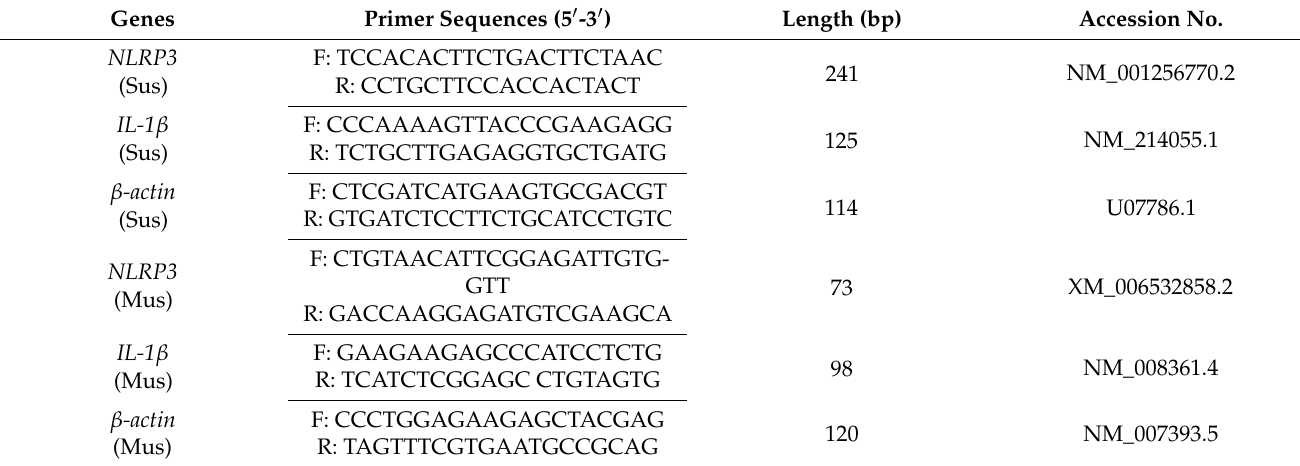
Table 1. Primers used for